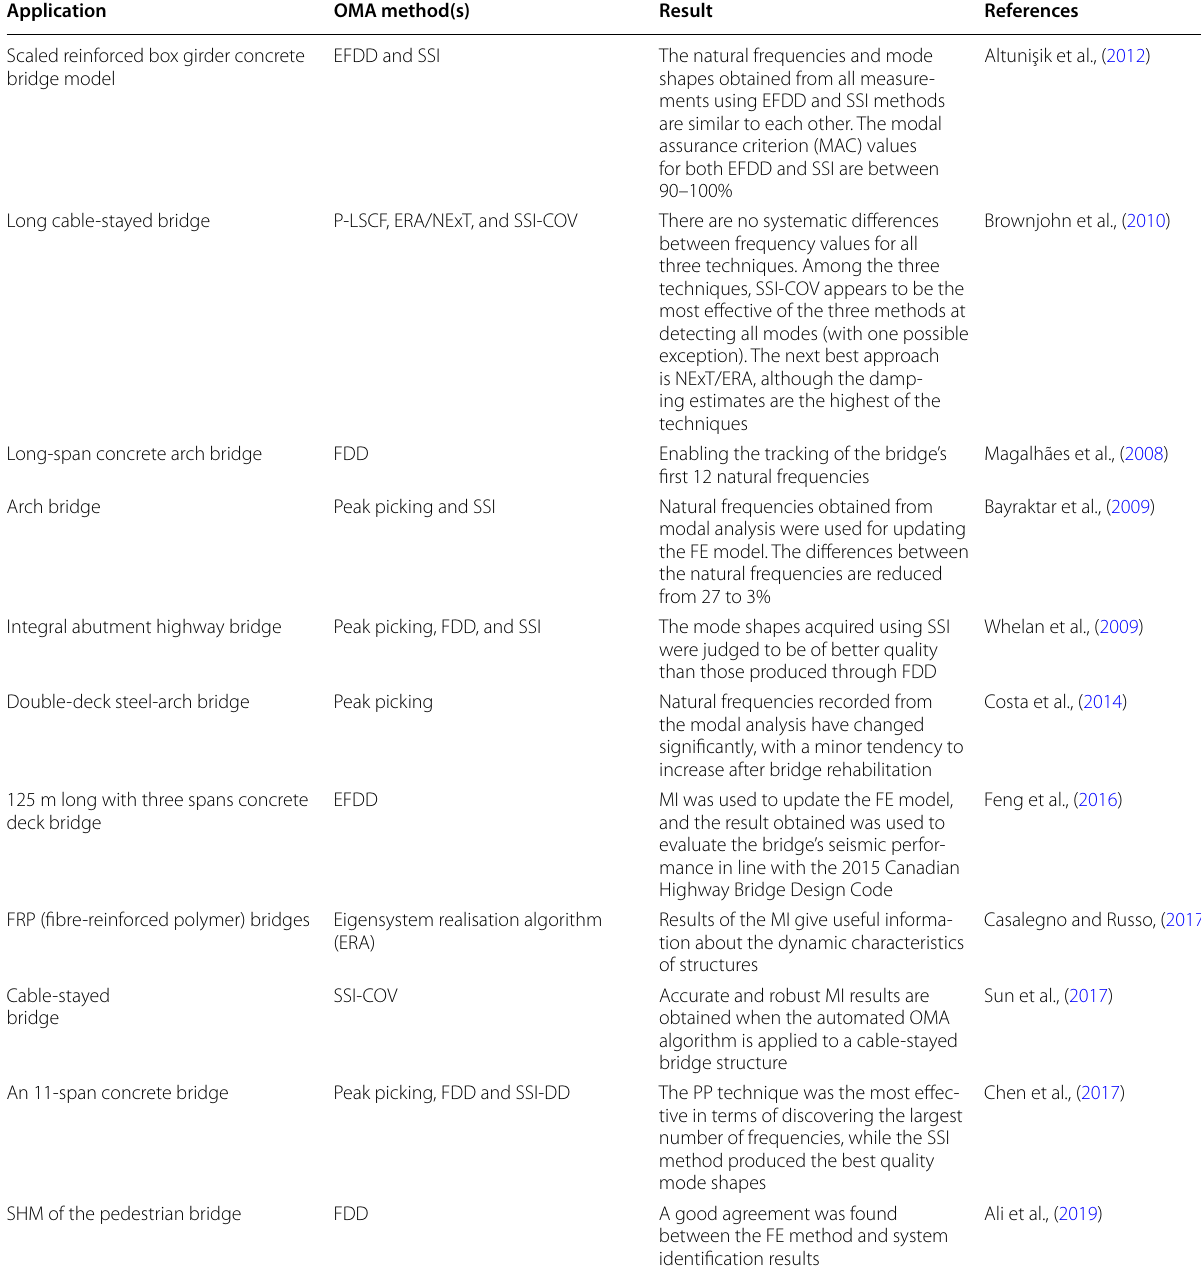
Table 6 Summary of OMA applications for bridge